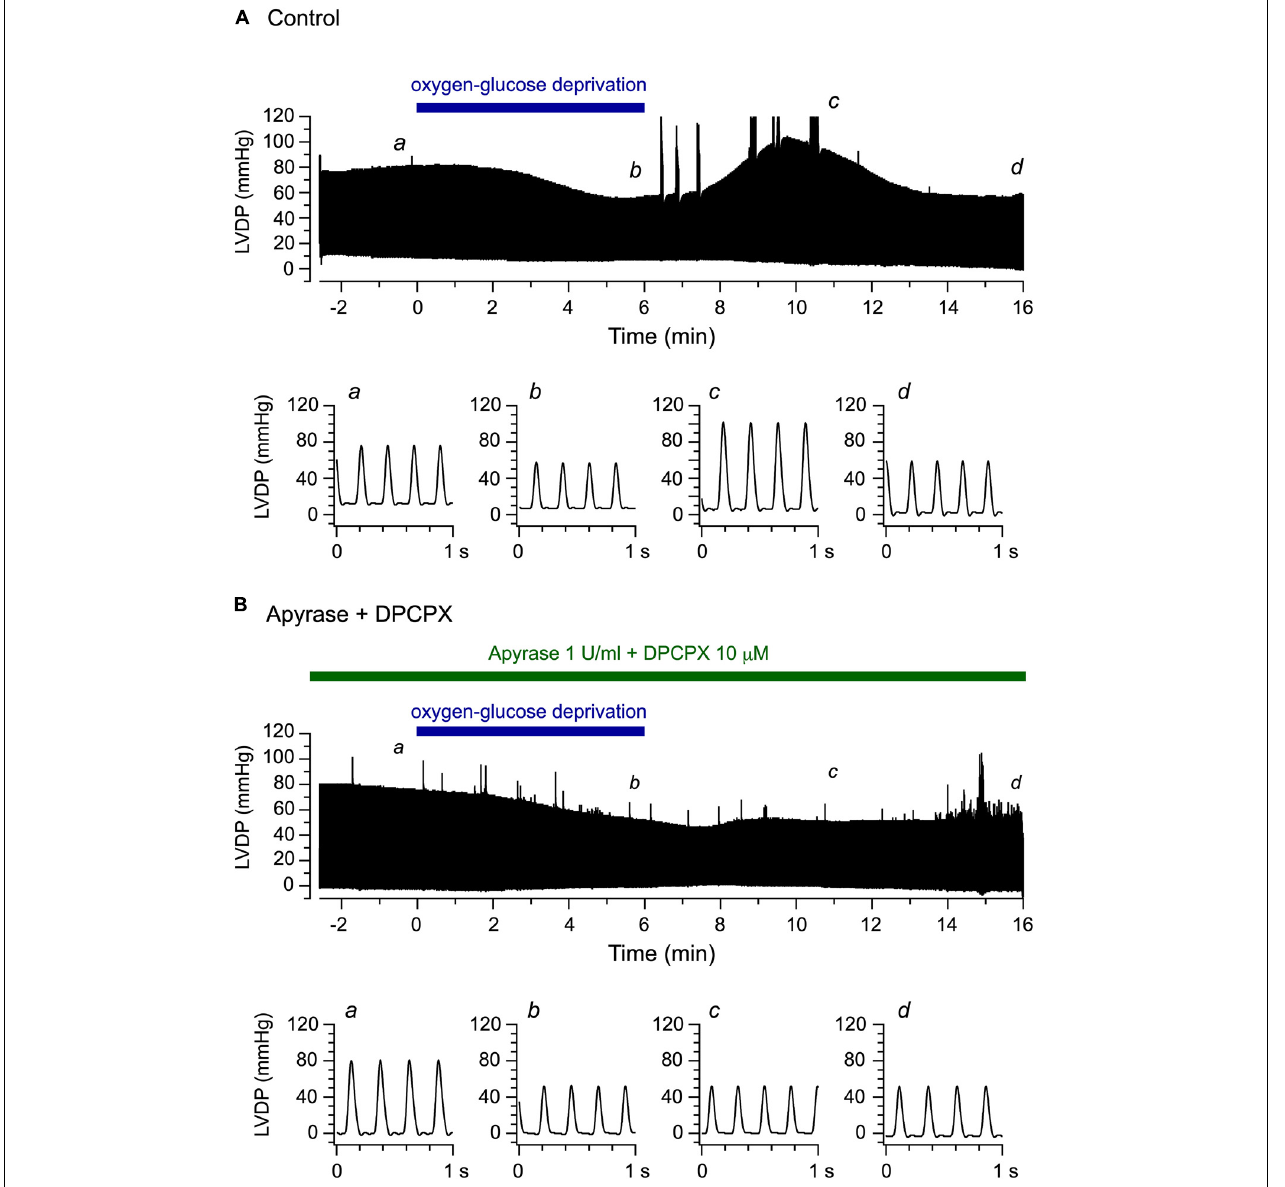
FIGURE 2 | Effects of oxygen-glucose deprivation (OGD) and reperfusion with an oxygenated, glucose-containing solution on the left ventricular function of the Langendorff-perfused mouse heart model. (A,B) Continuous traces of left ventricular pressure recorded before, during and after 6-min OGD in the absence (A) and presence (B) of 1 U/ml apyrase and 10 µ M DPCPX (upper panels). Lower panels illustrate original traces of left ventricular pressure, recorded at a , b , c , and d in upper panels, on expanded time